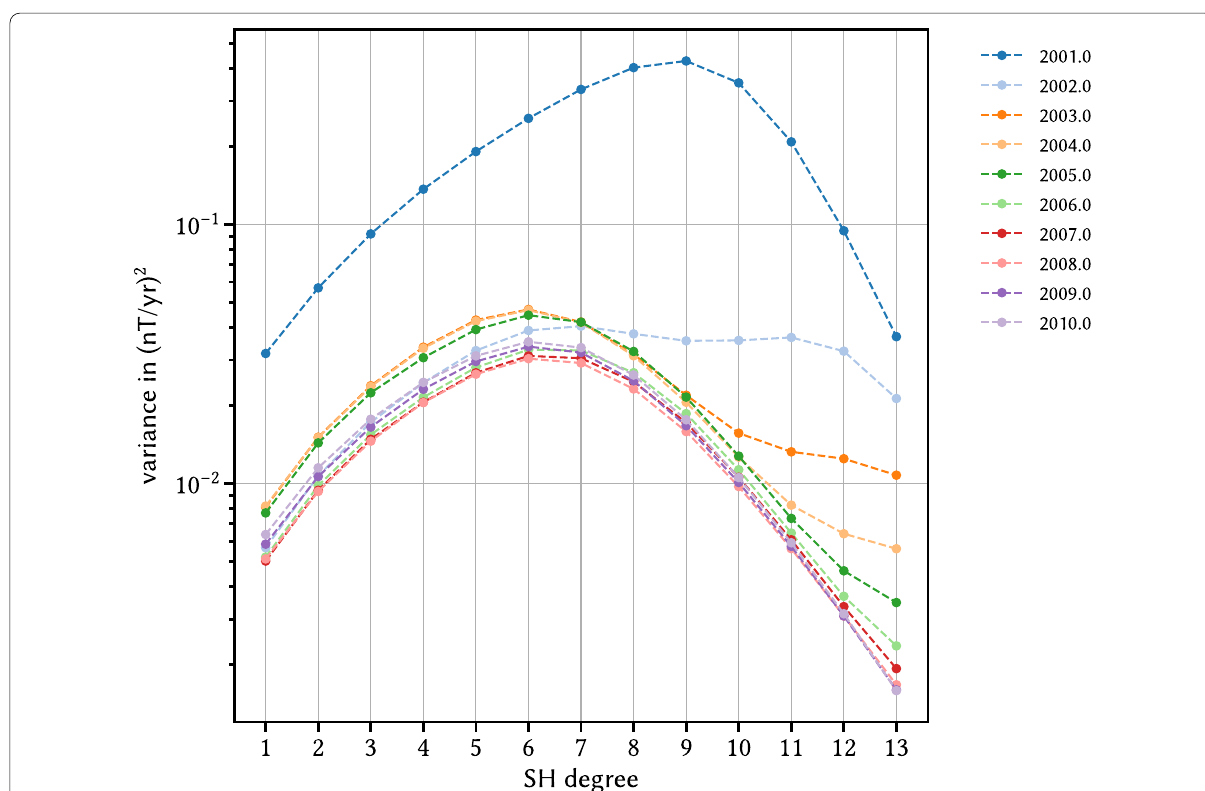
Fig. 5 Lowes–Mauersberger spectra of the variance of a series of secular variation models constructed sequentially between 2001.0 and 2010.0, by Kalman filtering, using an analysis step of one year, and all the satellite data available over the period. The SV is assumed constant over each interval of width one year. The variances are the diagonal coefficients of the posterior covariance matrix generated by the Kalman analysis step (no sequential smoothing is performed). See text for